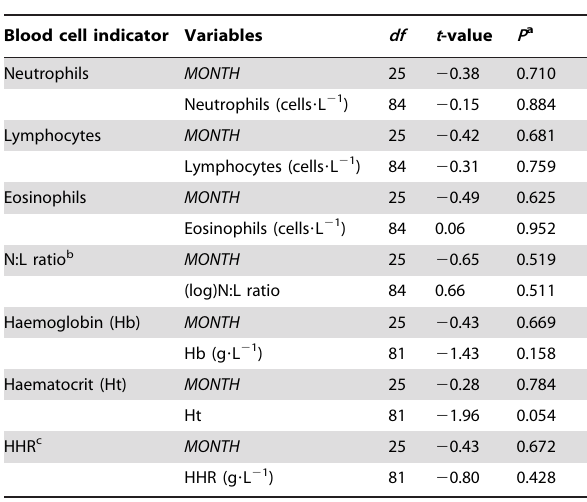
Table 2. Relationships between blood cell indicators of stress and health status and Mass-Size Residuals (g) for female agile